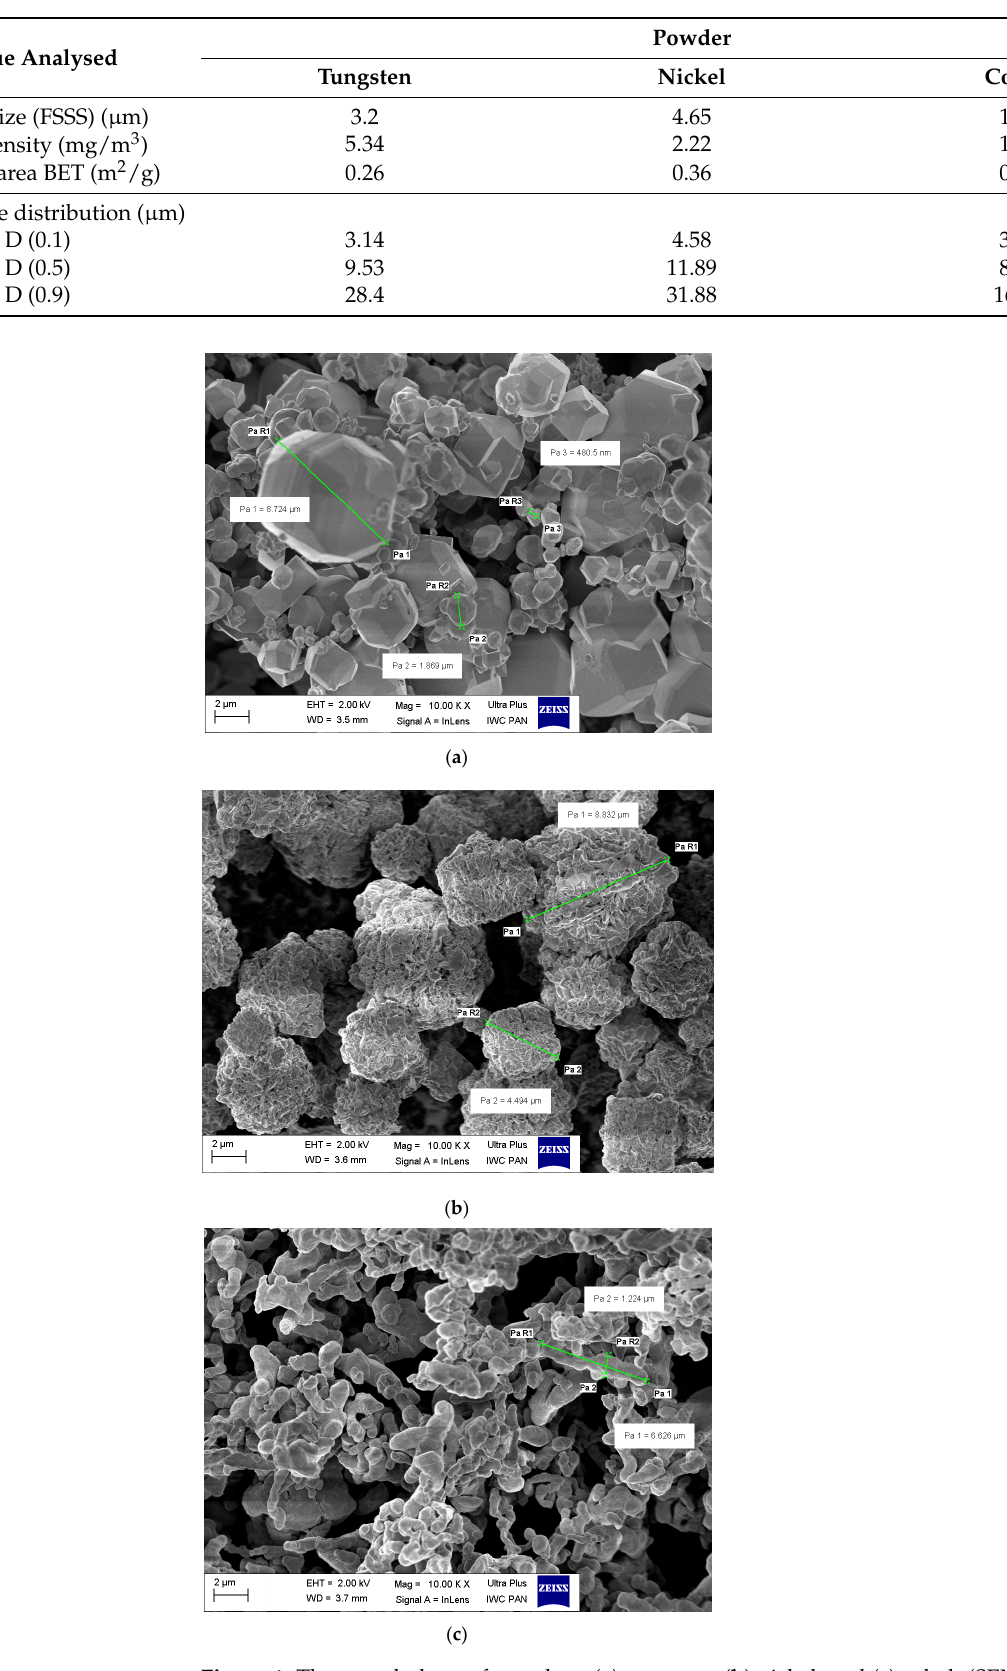
Figure 1. The morphology of powders: ( a ) tungsten, ( b ) nickel, and ( c ) cobalt (SEM).